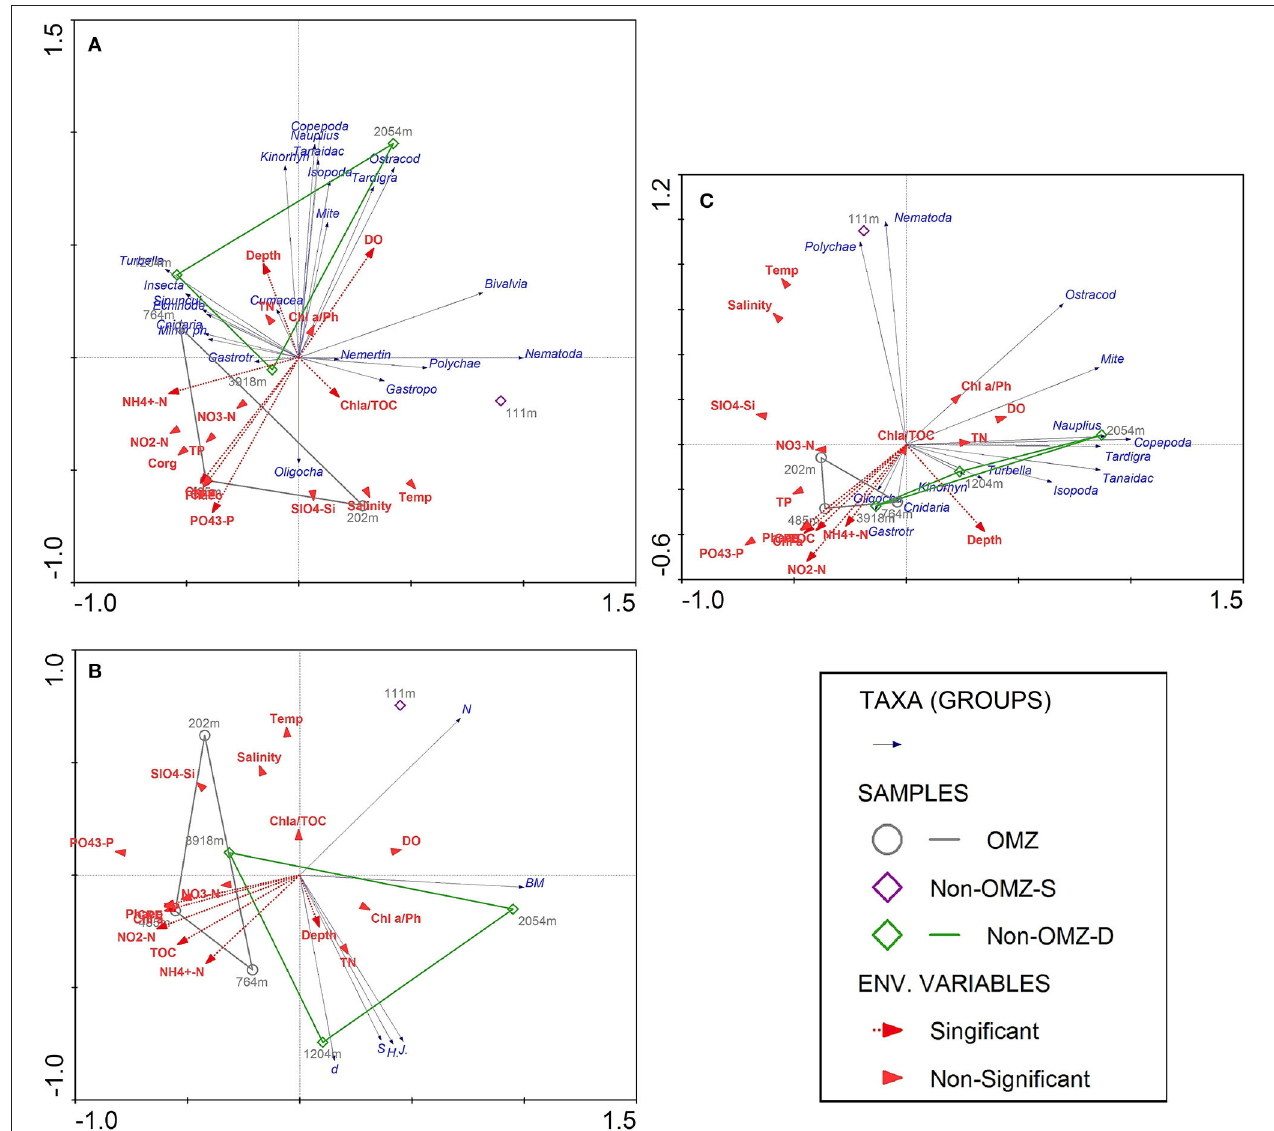
FIGURE 9 | Redundancy analysis (RDA) depicting the meiofauna community of seven sites sampled along the WICM and abyssal plain in relation to environmental variables and depth. Dashed red arrows represent the environmental significant variables (vectors) based on BIOENV procedures. Solid blue arrows are the meiofaunal taxa (responses). Arrows pointing in the same direction are correlated, and longer arrows indicate increasing values. (A) The first two axes explained 99.8% of the total variance of taxon abundance-environment variance; (B) The first two axes explained 100% of the total variance of meiofaunal diversity-environment variance; (C) Biomass-environment variance was explained by 99% of the first 2 axis